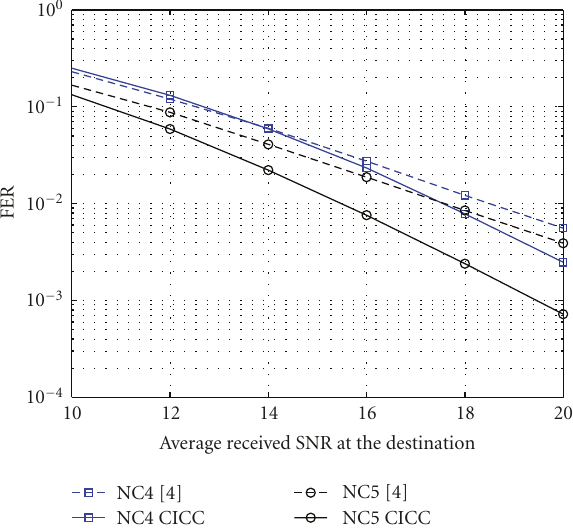
Figure 15: Performance comparison of the proposed 8PSK codes for classical [4] and CI coded